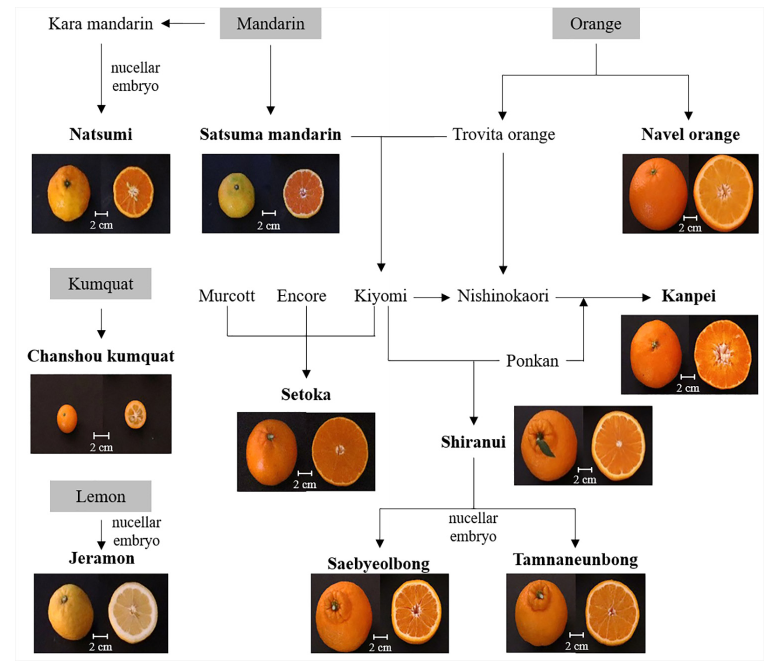
Figure 1. Appearance and parentage of 10 citrus varieties.